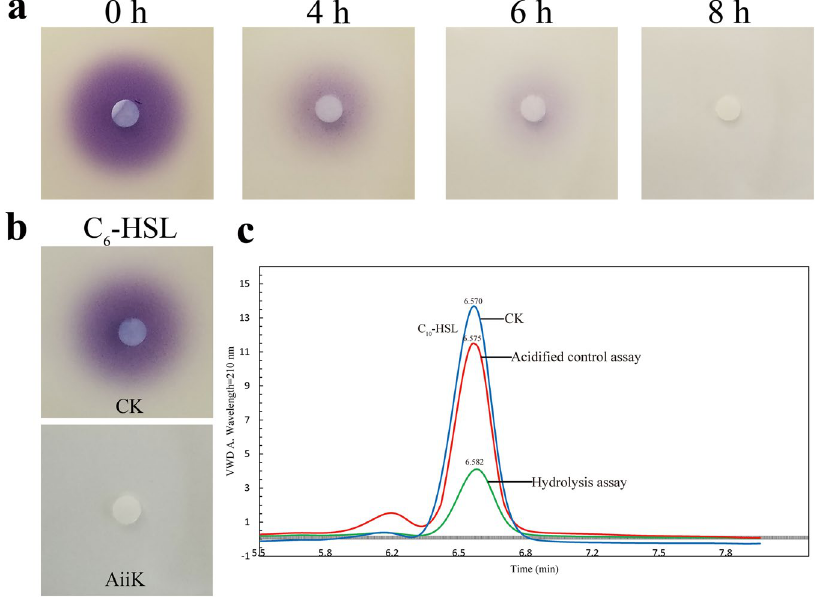
Figure 2. ( a ) AHL-degrading activity bioassays in vivo . Subcultures of E. coli BL21 (DE3) cells harboring pET32a- aiiK were mixed with 10 μ M C 6 -HSL and incubated at 37 °C for 0 h, 4 h, 6 h, 8 h, respectively. ( b ) AHL-degrading activity bioassays in vitro . The purified AiiK (4 μ g/mL) were mixed with 10 μ M C 6 -HSL and incubated at 25 °C for 1 h. CK means controls of PBS with the same amount of C 6 -HSL. The residual AHL was detected using strain C. violaceum CV026. ( c ) HPLC analysis of C 10 -HSL degradation. CK means controls of PBS with the same amount of C 10 -HSL; hydrolysis assay (AiiK: 4 μ g/mL, C 10 -HSL: 50 μ M) was carried out at 25 °C for 10 min, and then SDS was used to terminate the reaction; acidified controls assay (AiiK: 4 μ g/mL, C 10 - HSL: 50 μ M) was performed at 25 °C for 10 min, and SDS was used to terminate the reaction. The mixture was acidified to pH 2 by adding concentrated HCl and incubated at 25 °C overnight without agitation. The elution time of C 10 -HSL was at 6.57 ± 0.01 min and C 10 -HSL was monitored at 210 nm. All experiments were carried out in triplicates.